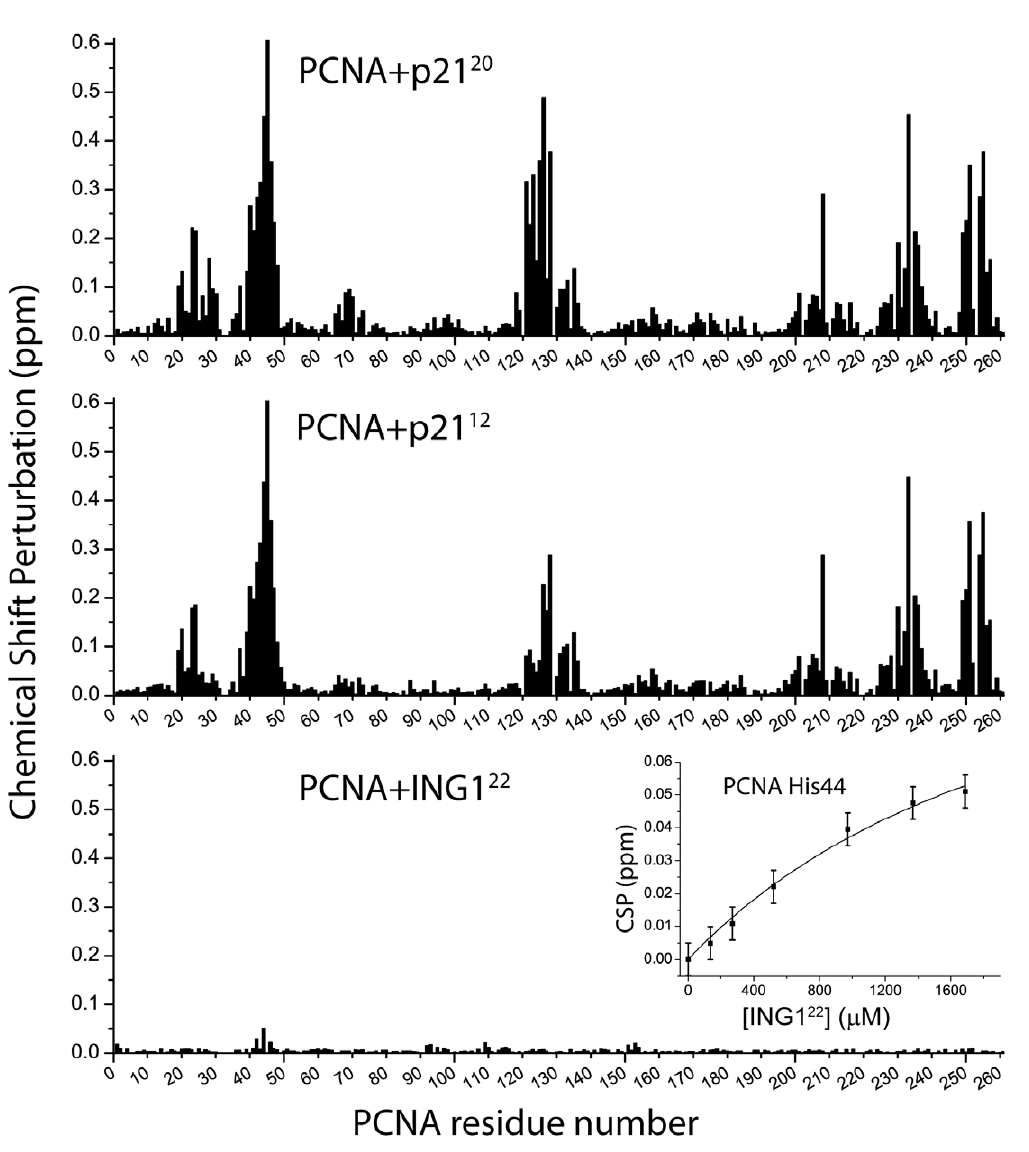
Figure 4. Chemical shift perturbations of PCNA backbone amide resonances caused by PIP-box peptides. The top and middle panels show the CSP values for each PCNA residue in the presence of a 1.2 or 1.6 excess (on a monomer basis) of p21 20 or p21 12 peptides, respectively. Under the experimental conditions used PCNA is saturated with the peptides (we calculate that 99.9 and 99.8% of the PCNA molecules are bound to the p21 20 or the p21 12 peptide, respectively). The bottom panel represents the CSP values in the presence of a 7.8 excess of the ING1 22 peptide. The inset shows the CSP experienced by PCNA residue H44 at increasing concentrations of the peptide with error bars spanning twice the estimated uncertainty in the CSP values ( 6 0.005 ppm), which is the average CSP value. The line is the best fit to a model of one set of identical binding sites.